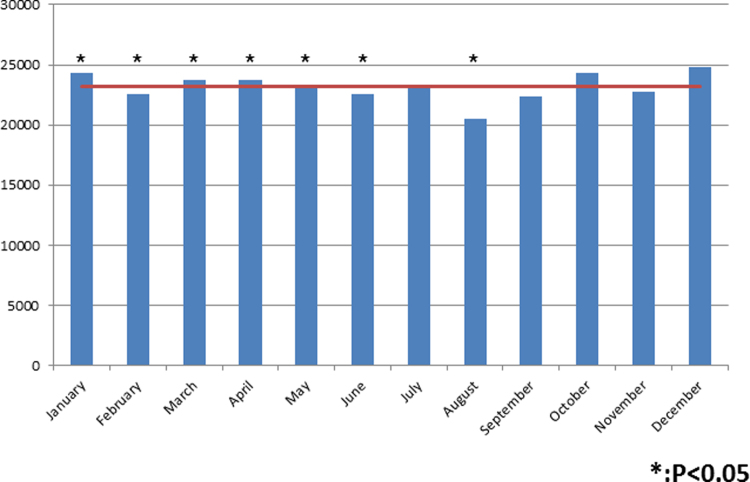
monthly variations of admissions in ICCUs. .